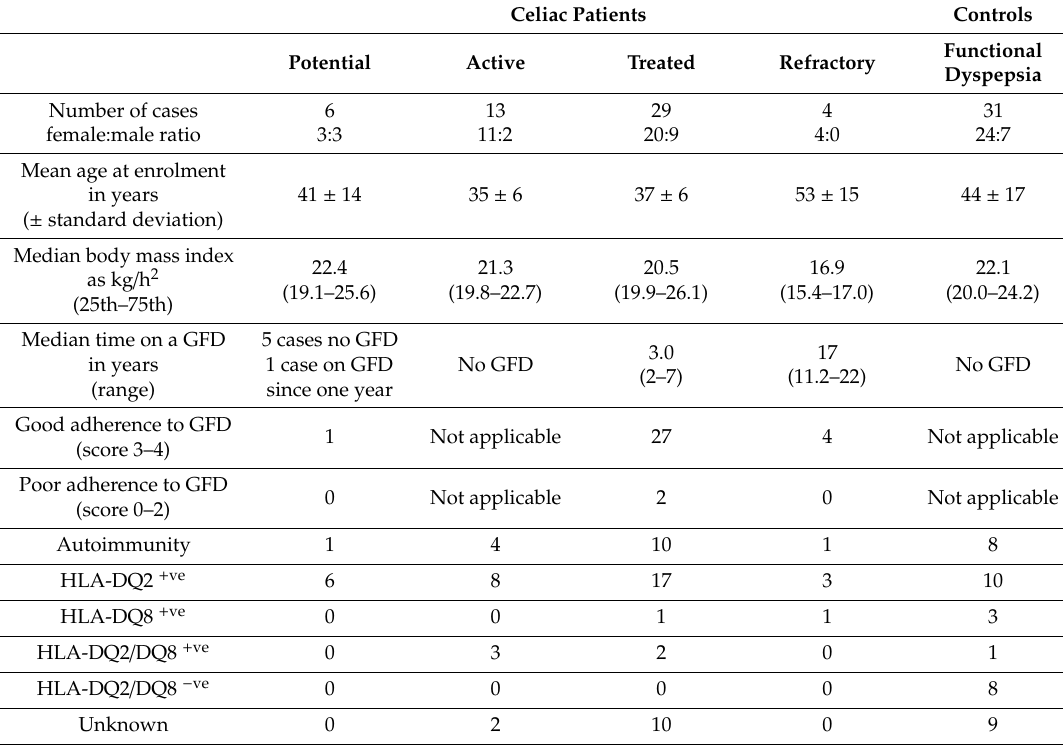
Table 2. Demographic and clinical features of study